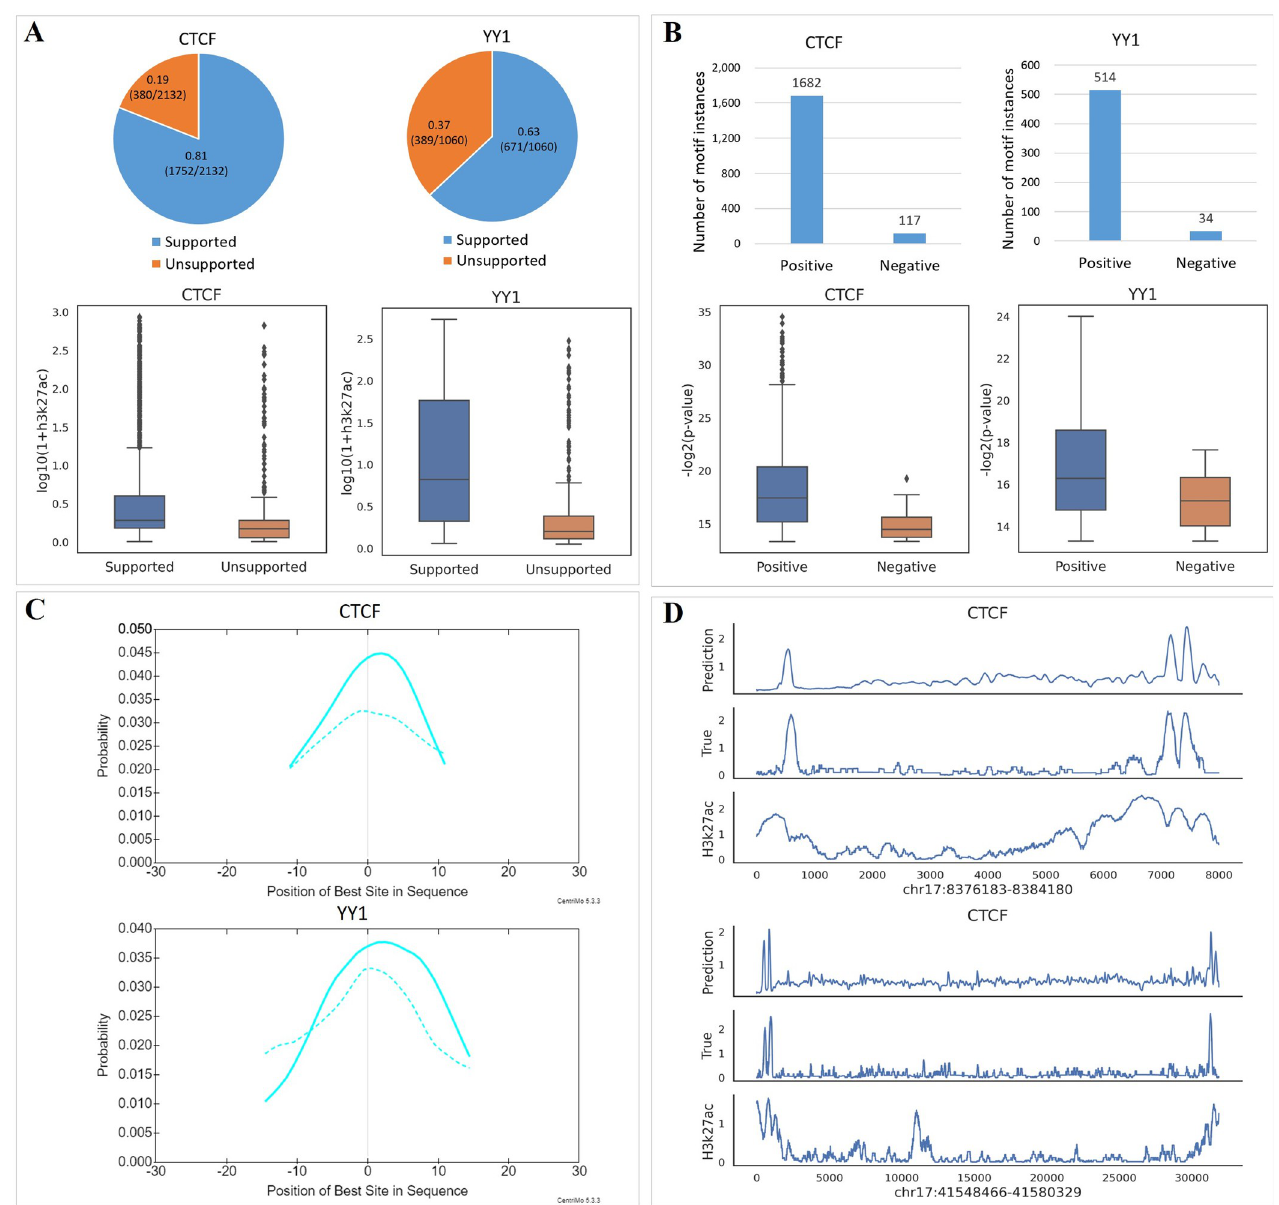
Fig 4. The performance of FCNsignal in locating TF-DNA binding regions. (A) The results of FCNsignal in locating potential binding regions for CTCF and YY1 on the whole chromosome 17 as well as the distribution of h3k27ac signals in the supported and unsupported sequences, where ‘Supported’ means existing in the real peaks and ‘Unsupported’ means the opposite. (B) The number of motif instances found by FIMO on the located regions and the negative regions as well as the distribution of the matched–log2(p-value) values. (C) The motif enrichment analysis on the located regions and the negative regions. The dash lines represent the results on the negative regions. (D) The base-resolution signals of DNA sequences of arbitrary length predicted by FCNsignal, the true signals, and the h3k27ac signals. The range of the top DNA sequence is chr17: 8376183–8384180 (7997bp length), and the range of the bottom DNA sequence is chr17: 41548466–41580329 (31863bp